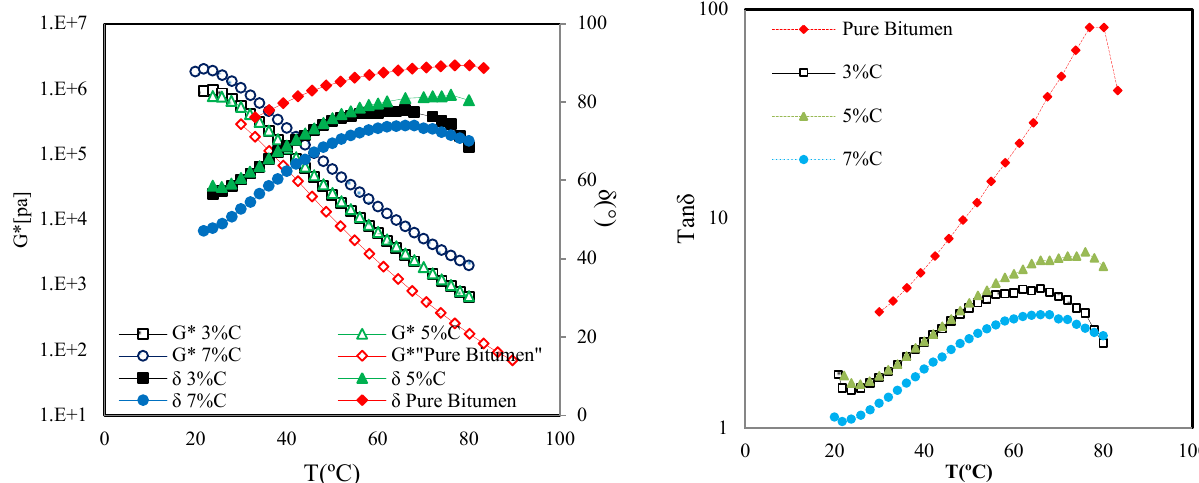
Fig. 3. Complex modulus/phase angle (left) and Tanδ (right) curves for the bitumen modified by blend C.